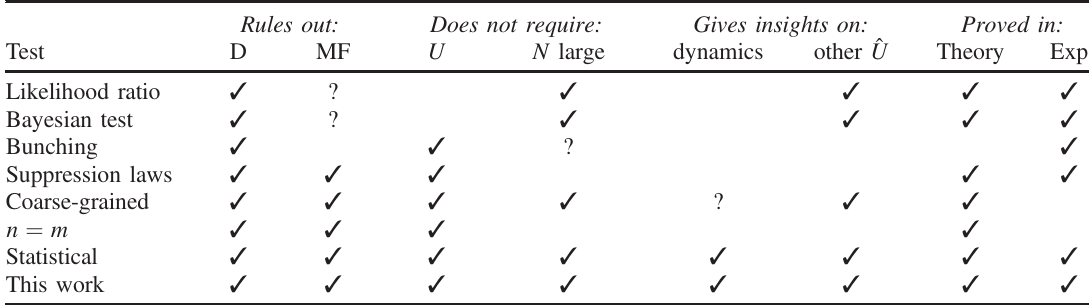
TABLE I. Summary of the available protocols to validate quantum interference (Q) against experiments with distinguishable photons (D) or mean-field states (MF). Ideal validations should be reliable and efficient, meaning that they should not require resources exponential in the size of the problem, neither computational (e.g., the evaluation of permanents) nor physical (e.g., in the number of samples N ). Also, they could provide insights on the multiphoton dynamics for a given transformation, as well as being applicable to conditions other than Q, D, or MF. LR, likelihood ratio [17,20,23 – 25]; ZTL, zero-transmission law (or suppression law) [21,34,40 – 45];